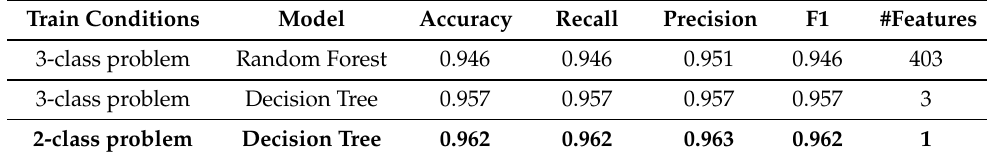
Table 7. Classification results for shadows and reflections using an independent ML model for CT.